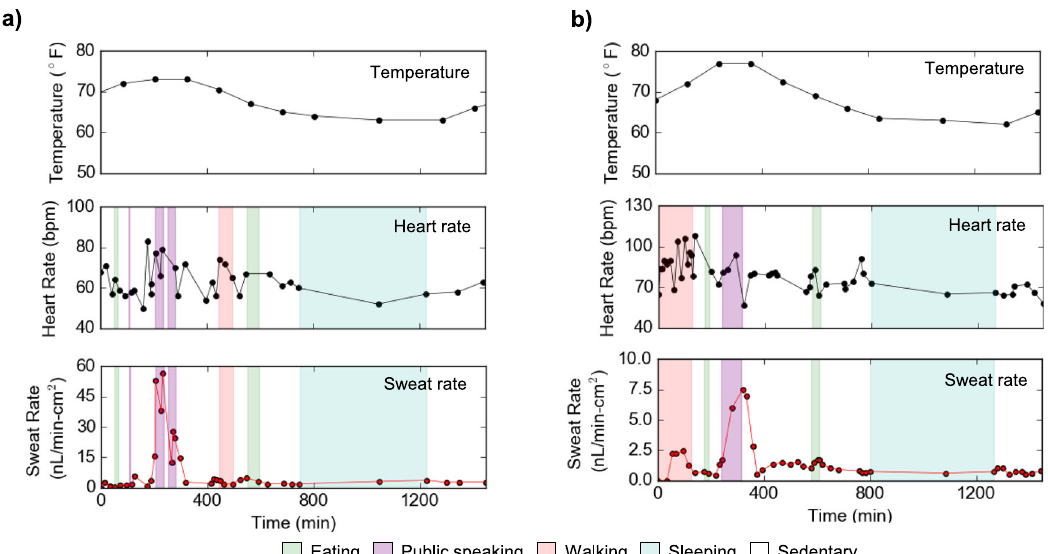
Fig. 5 Twenty-hour in situ sweat analysis to identify stress events among routine activities. Sweat is monitored on the fi ngertip of a healthy volunteer along with heart rate and ambient temperature as the mostly sedentary subject performed intervals of public speaking ( a ) during a live-streamed academic conference in Trial 1, and ( b ) while teaching a class in Trial 2. The stress-inducing intervals of public speaking are associated with elevated heart rate and a sharp increase in sweat